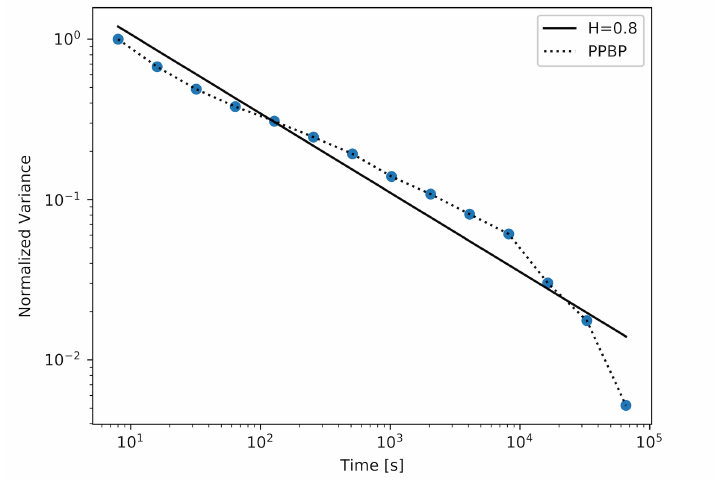
Figure 6. The aggregate variance of the sample in several time scales with the PPBP